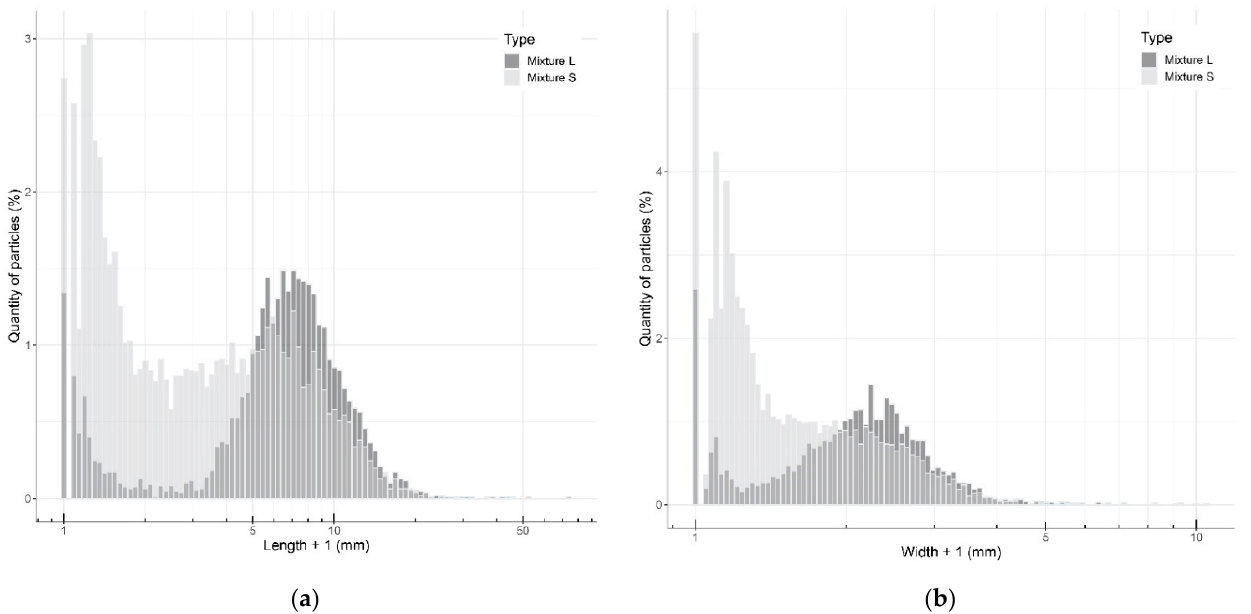
Figure 2. This figure shows the difference between the distribution particles’ dimensions in both mixtures (L for large and S for small). The x -axis is displayed on a log-scale. Due to the presence of 0s in the data (emerging from micro-particles), which equal - ∞ on a log-scale, the data was offset by adding 1 to every value. Particles shown at 1 mm represent any micro-particles detected measuring less than 0.01 mm; ( a ) shows the distribution of particles’ length + 1 in both mixtures; ( b ) shows the distribution of particles’ width + 1 in both mixtures.